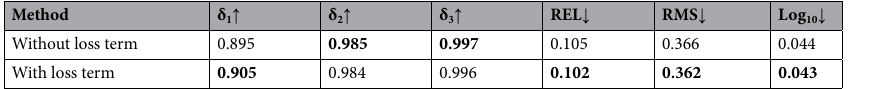
Table 10. Quantitative comparison of different loss functions for pixel-level depth of block1 to block4 . The better results are shown in bold.